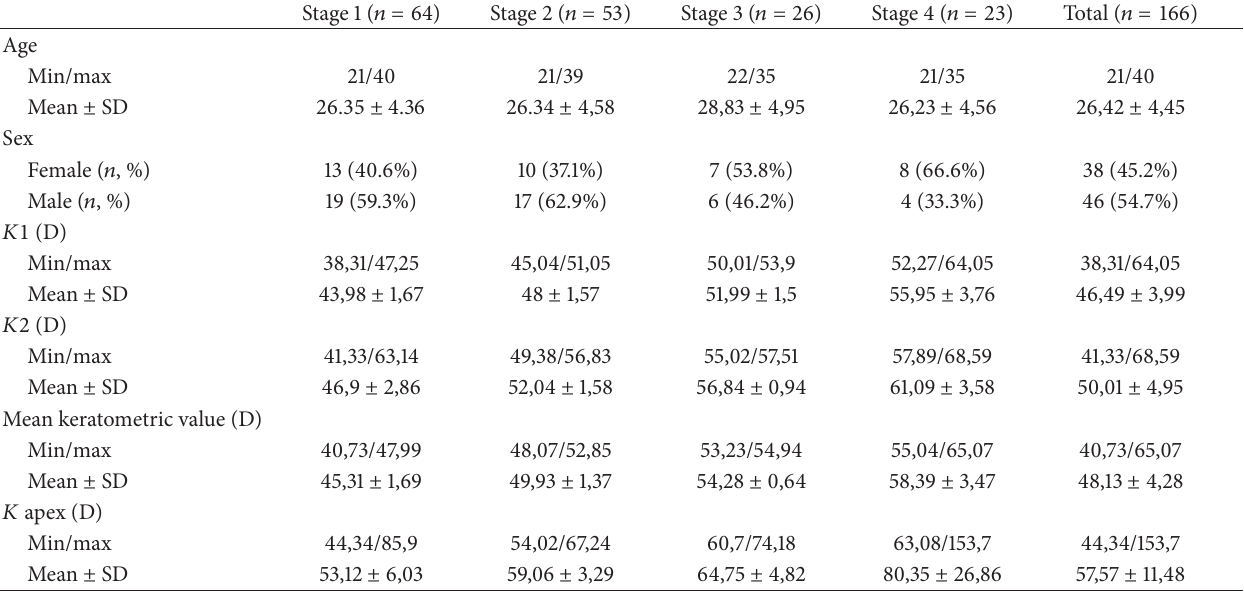
Table 1: Patient